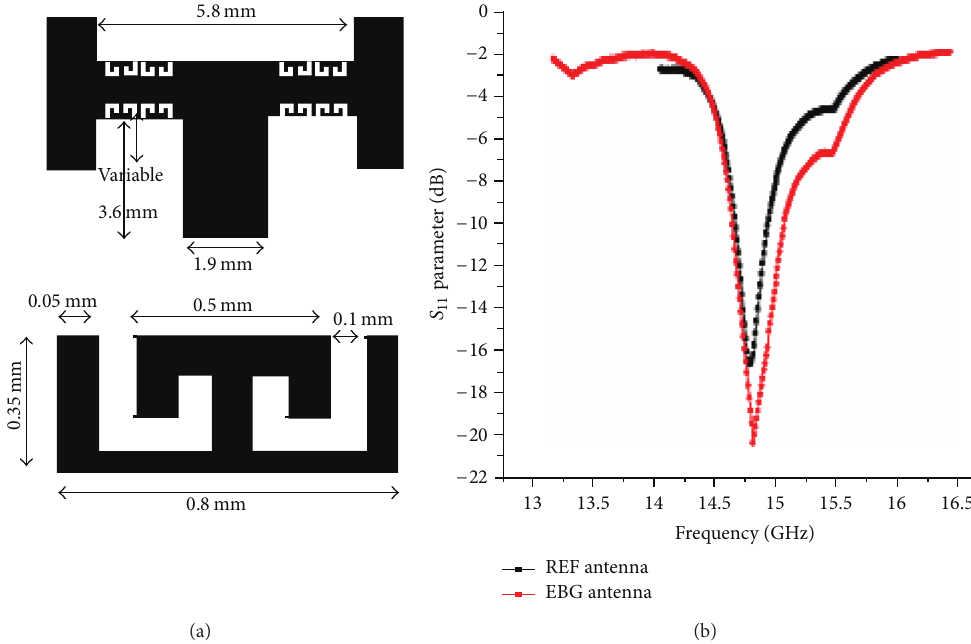
Figure 16: (a) Top: “dummy EBG” on feedline and bottom: magnified view of the EBG pattern; (b) measured 𝑆 11 parameters for reference and EBG antenna.